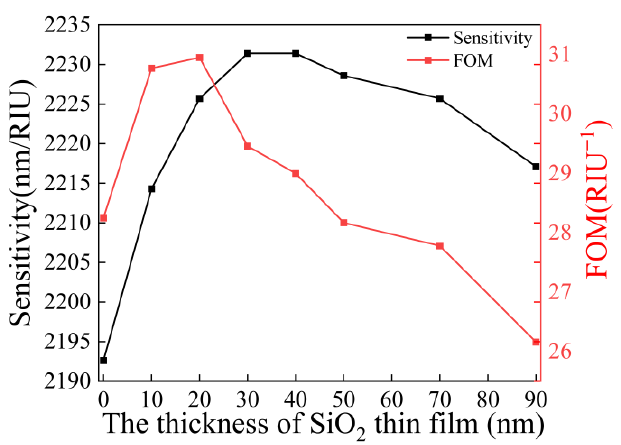
Figure 4. Comparison of the sensitivity and FOM at different silica film thicknesses.